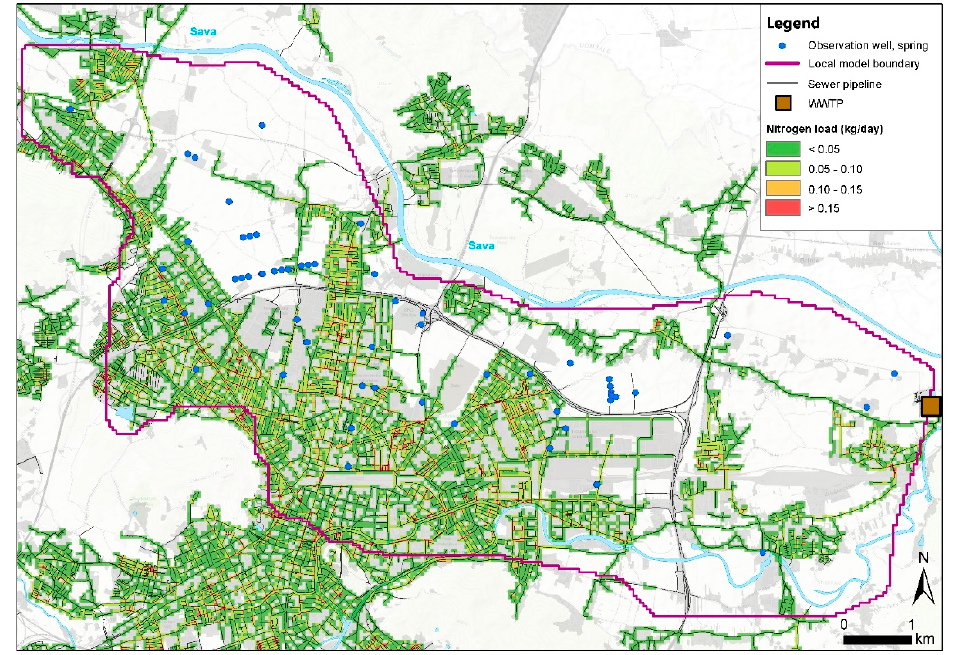
Figure 6. The spatial distribution of the estimated nitrogen load from the leaky sewer system (in kg/day per 50 m grid cell).